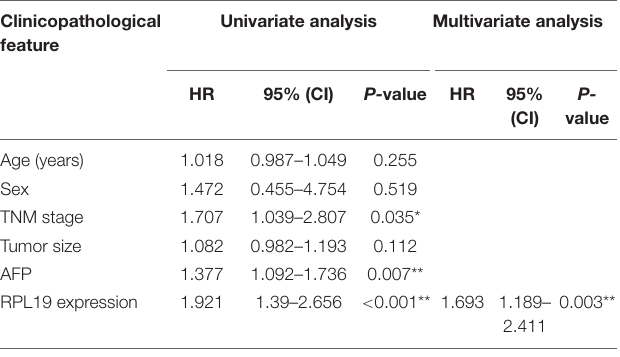
TABLE 4 | Univariate and multivariate analyses of the overall survival of hepatocellular carcinoma patients. Clinicopathological